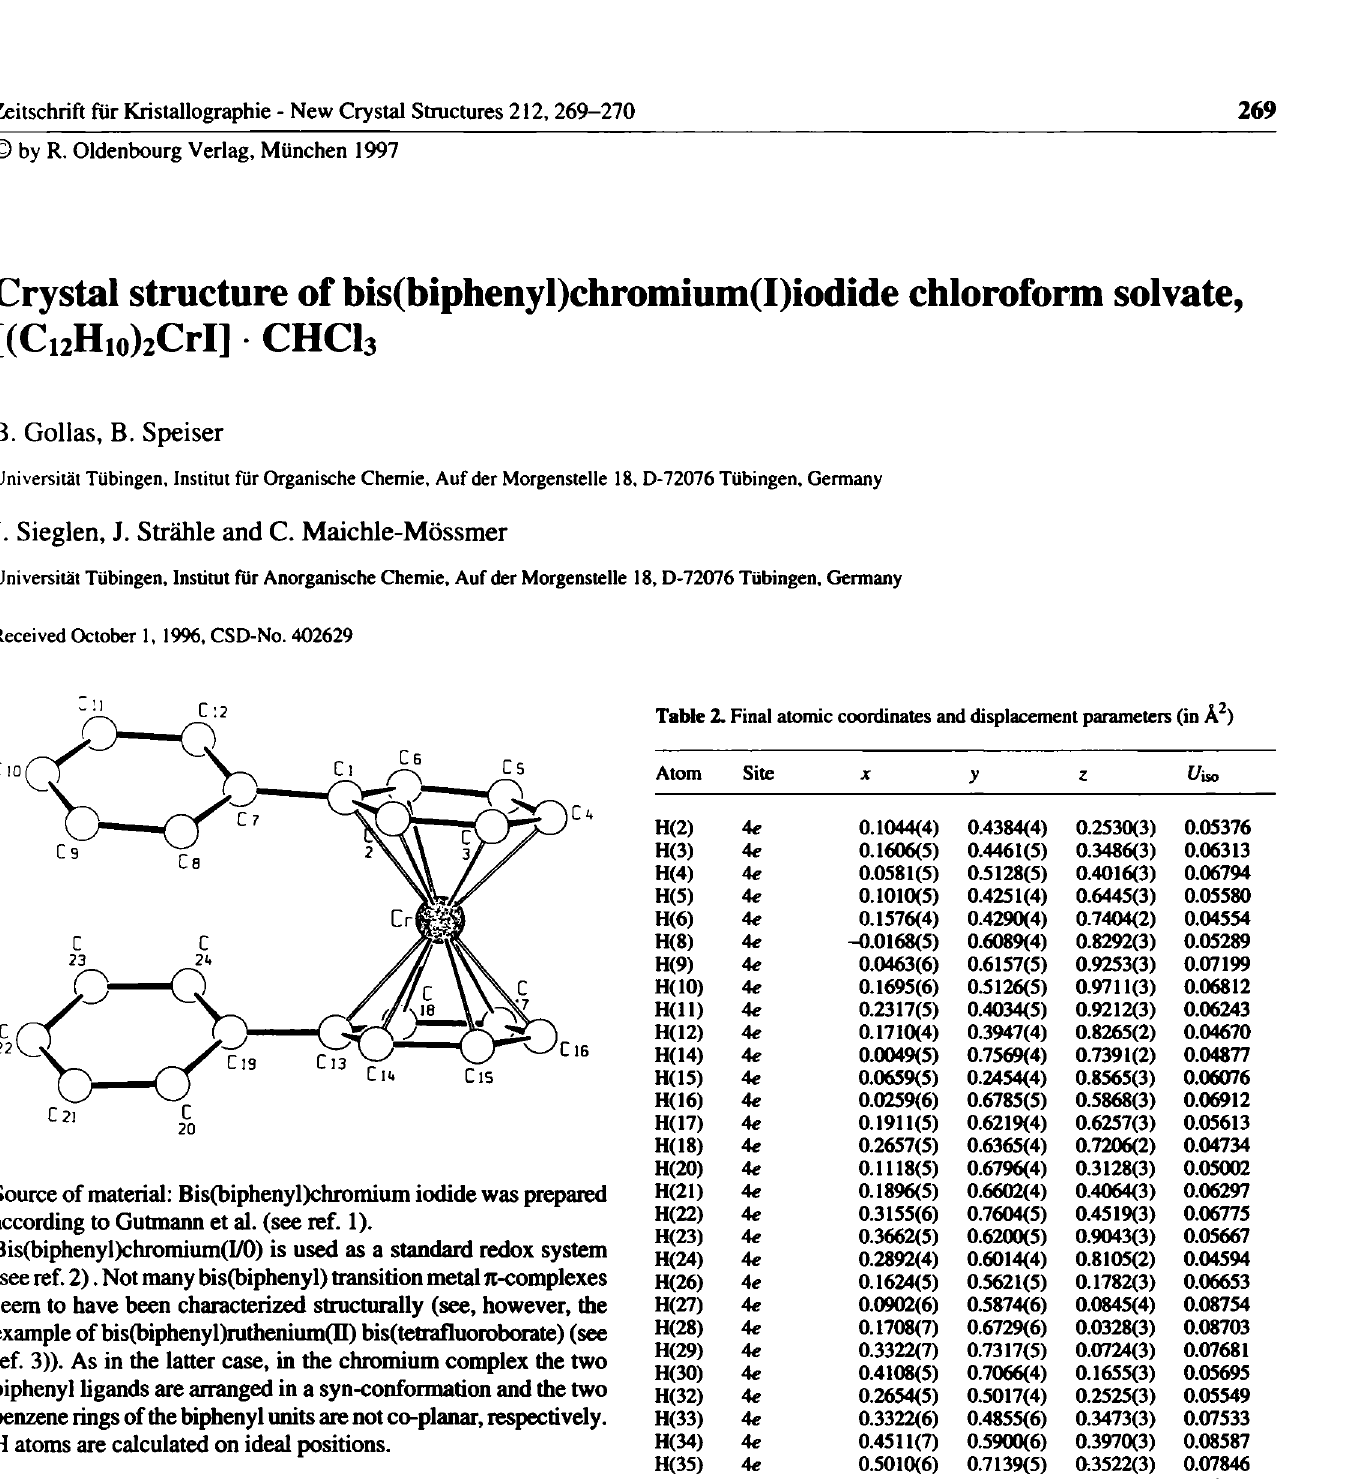
Table 1. Parameters used for the X-ray data collection Crystal: